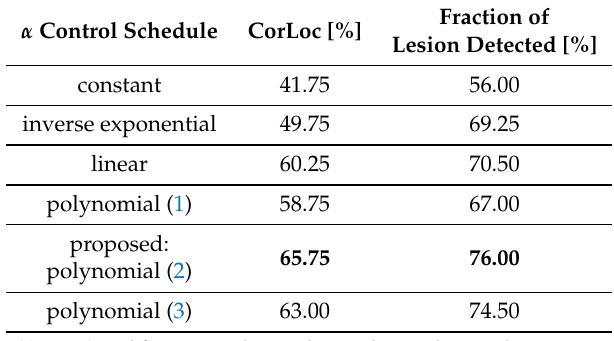
Table 2. Results showing variants of controled weight α with the SNUBH BUS dataset. α Control Schedule